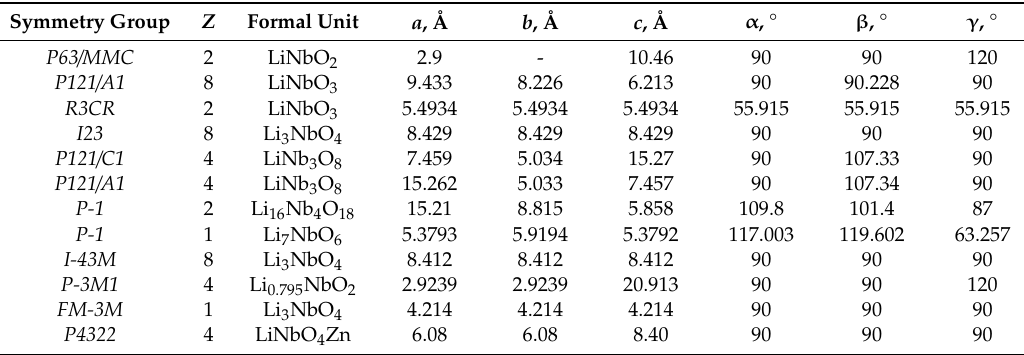
Table 5. A list of phases from the ICSD database.